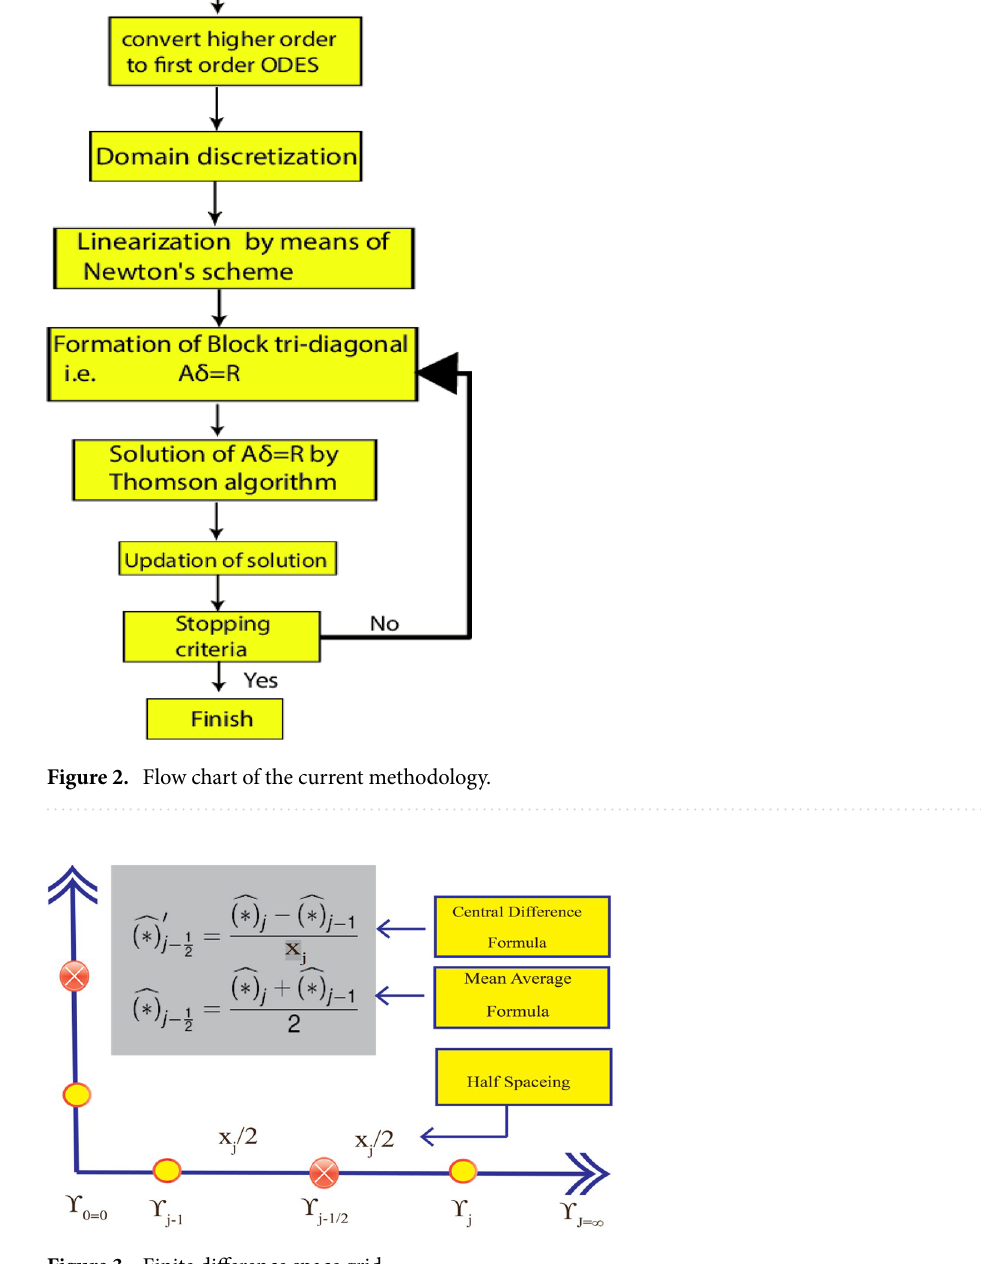
Figure 3. Finite difference space